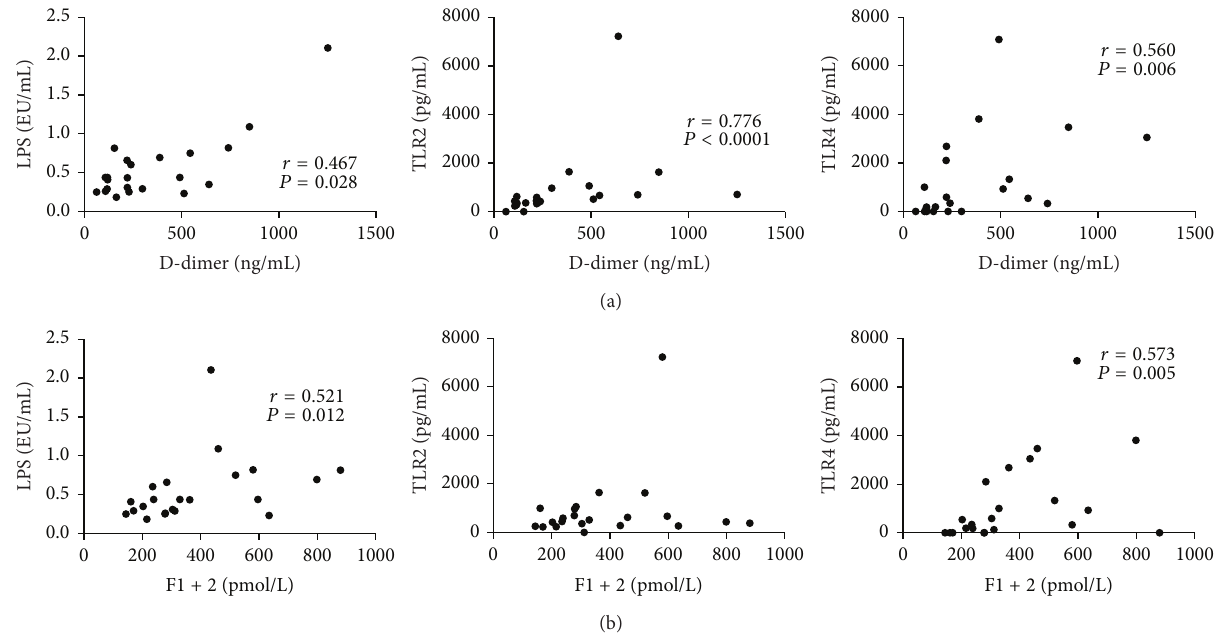
Figure 5: Circulating LPS, TLR2, and TLR4 correlate with markers of activated coagulation in UC patients. Concentrations of LPS, TLR2, and TLR4 and levels of D-Dimer and prothrombin fragment F 1 + 2 were measured in the sera and plasma, respectively, of UC patients. (a) Correlation between D-Dimer plasma levels and serum LPS, TLR2, and TLR4 in UC patients. (b) Correlation between prothrombin fragment F 1 + 2 and circulating LPS, TLR2, and TLR4 in UC patients. Statistical analysis was performed by means of Spearman Correlation Test. 𝑃 < 0.05 was considered statistically